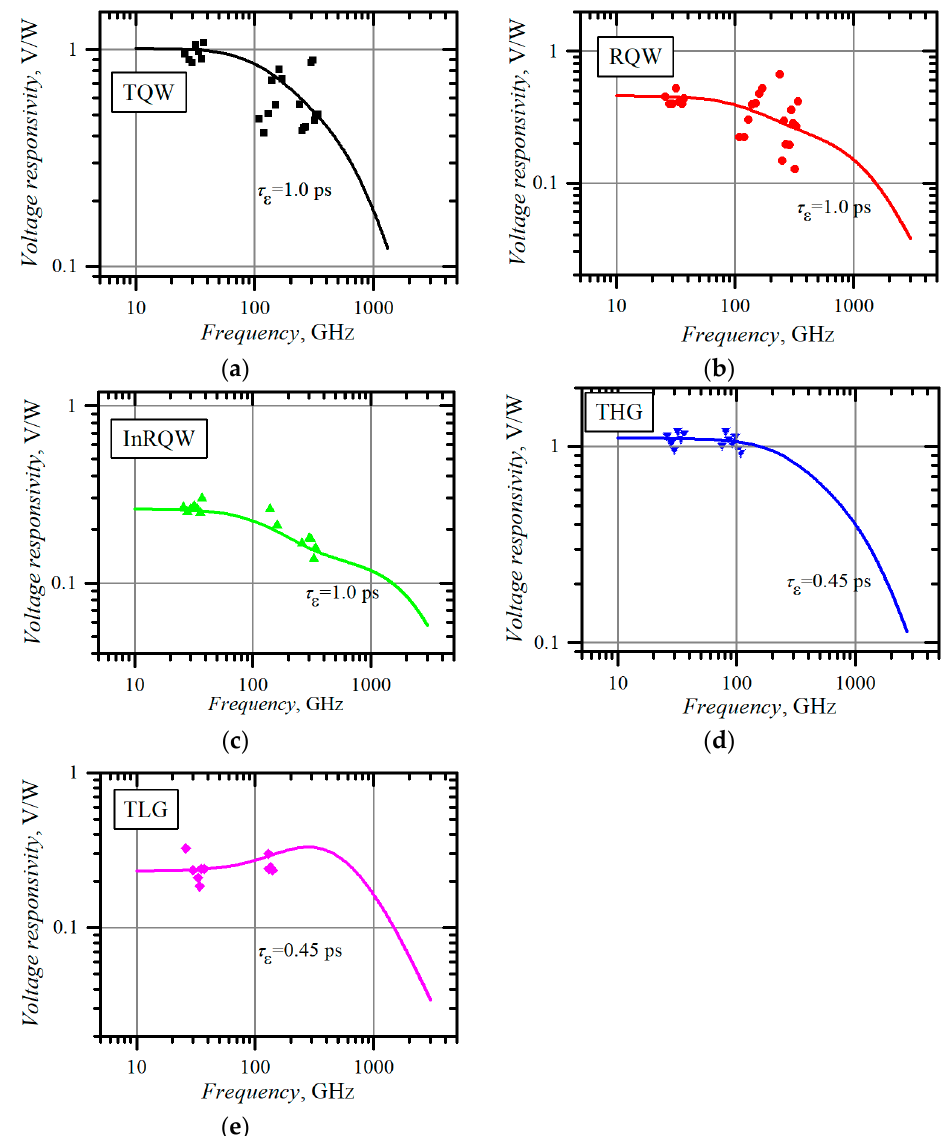
Figure 6. Experimental (points) and theoretical (lines) frequency dependence of the voltage responsivity of planar, asymmetrically necked MW diodes on the base of: ( a ) selectively doped AlGaAs/GaAs structure with a triangular quantum well, TQW; ( b ) AlGaAs/GaAs structure with a rectangular GaAs quantum well, RQW; ( c ) GaAs/InGaAs structure with a rectangular InGaAs quantum well, InRQW; ( d ) thin epitaxial heavily doped GaAs layer, THG; ( e ) epitaxial structure with a thick lightly doped GaAs layer, TLG.